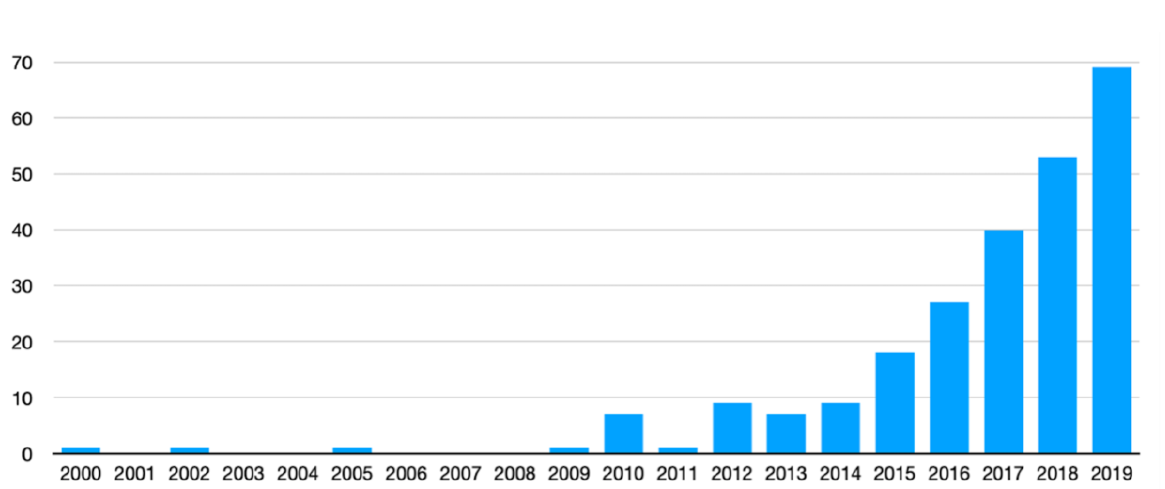
Figure 1. Number of publications, by year, found in search of Web of Science database, Feb. 12, 2020 .